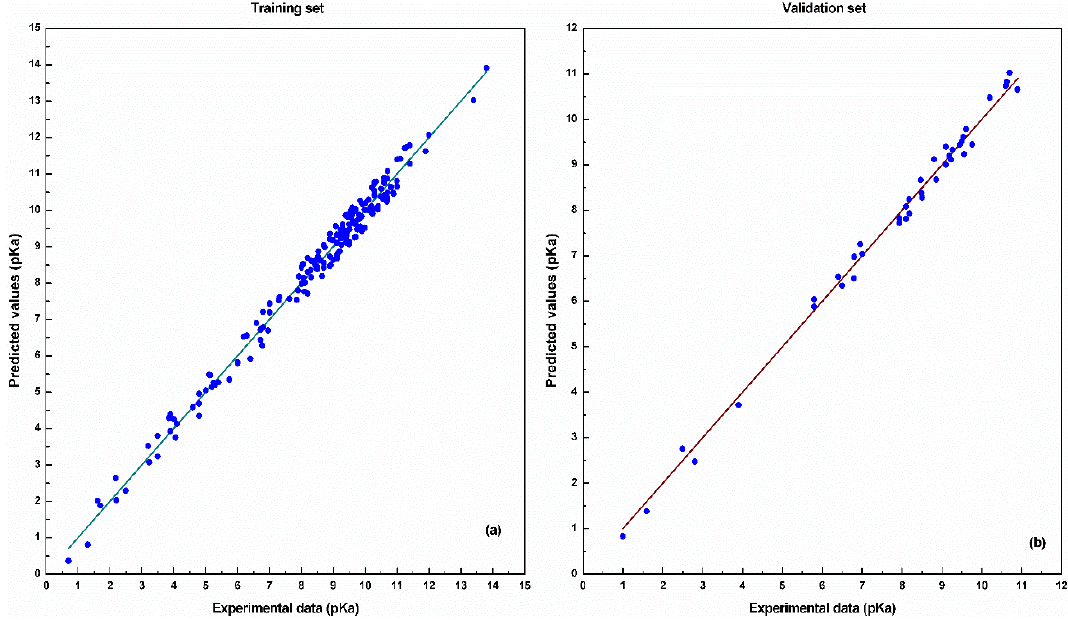
Figure 2. Comparison between the predicted and experimental values in the training and validation sets.